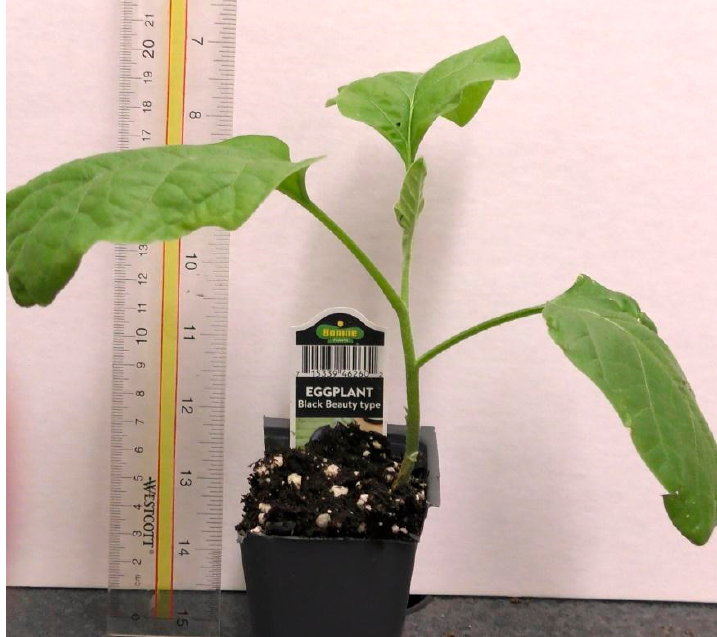
Figure A2. Eggplant.